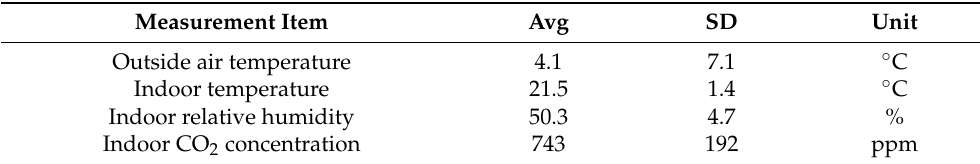
Table 4. Indoor environment during the measurement period.